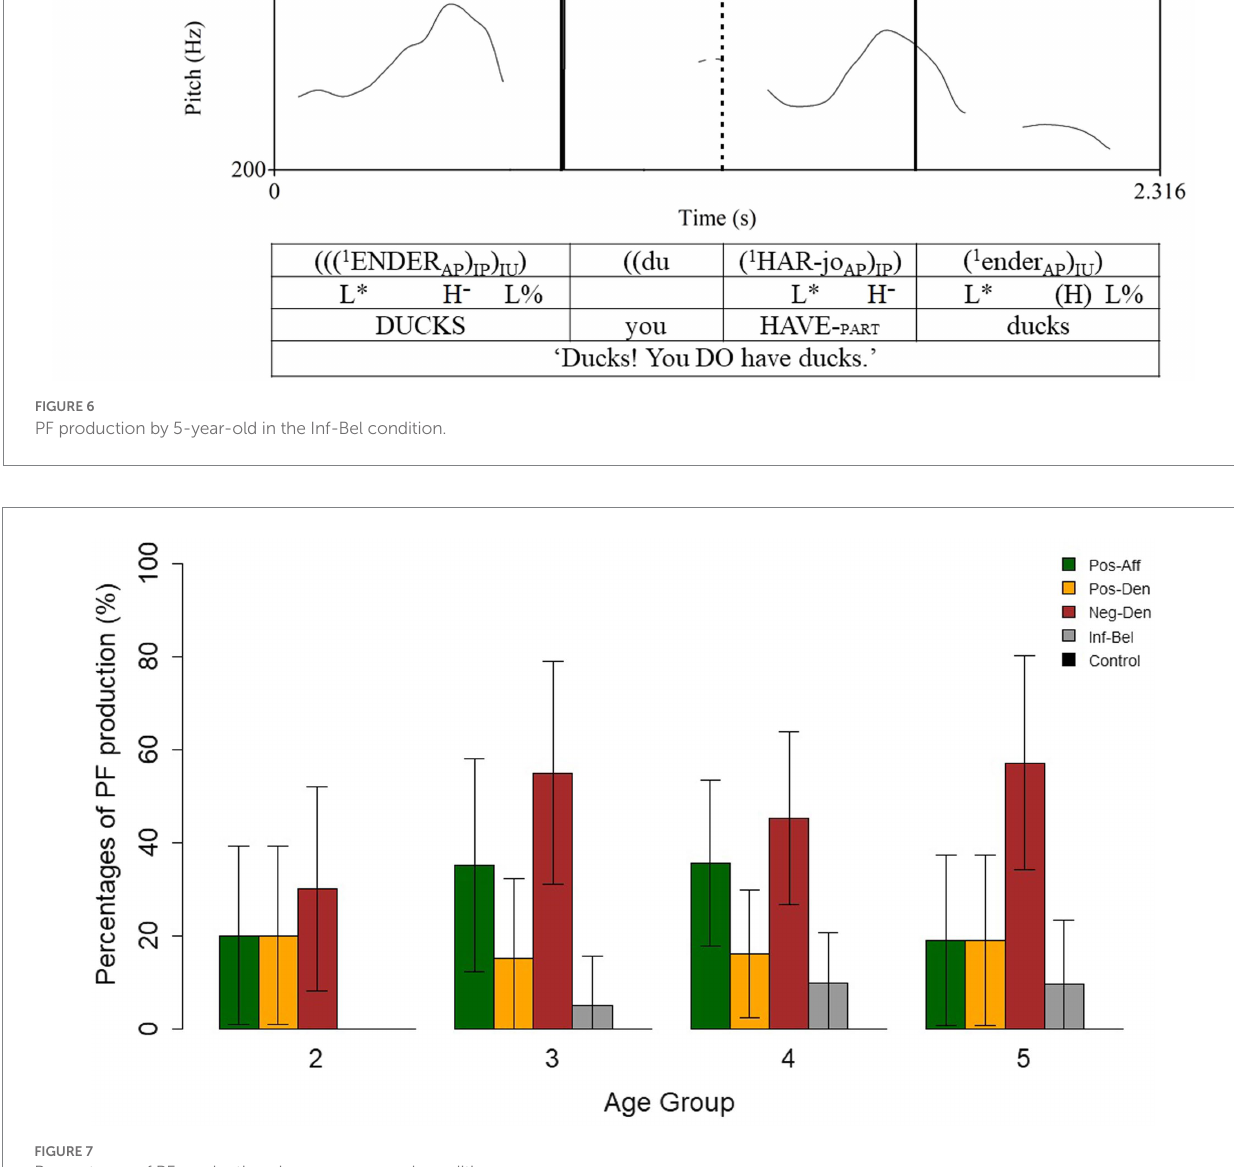
FIGURE 7 Percentages of PF productions by age group and